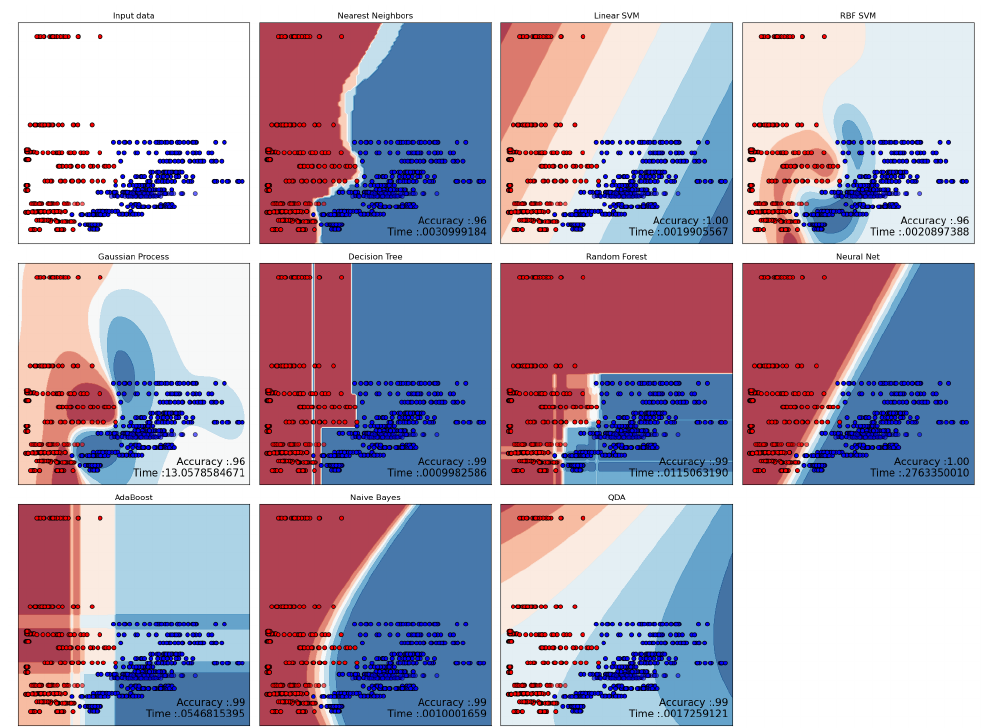
Figure 7. ExM value and weight values visualization of the two classes (Coal in blue and gangue in Red), Cross-validation test for “Nearest Neighbors”, “Linear SVM”, “RBF SVM”, “Gaussian Process”, “Decision Tree”, “Random Forest”, “Neural Net”, “AdaBoost”, “Naive Bayes”, and “QDA” with the decision boundaries display, classification accuracy in a scale of (0–1) and time in seconds. Table 5. ExM values cross-validation test, values of precision, recall, F1-score, accuracy, macro avg, and weighted avg are in an average scale of (0–1), where time in